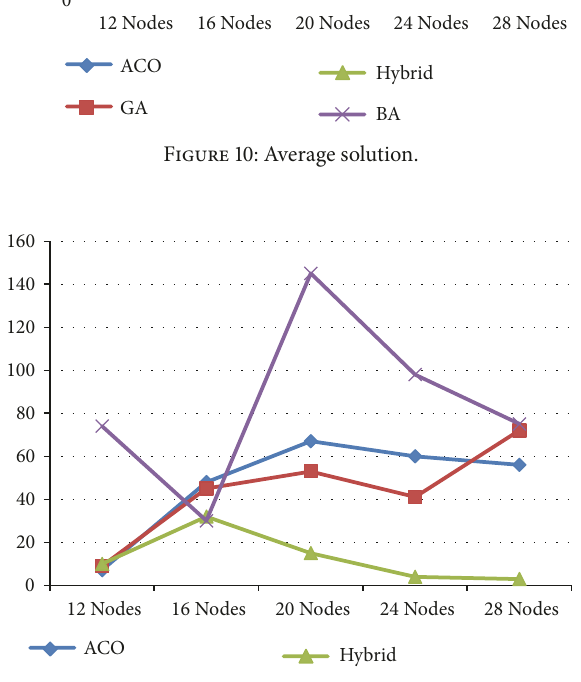
Figure 11: Range of solutions of ACO, GA, hybrid ACO-GA, and